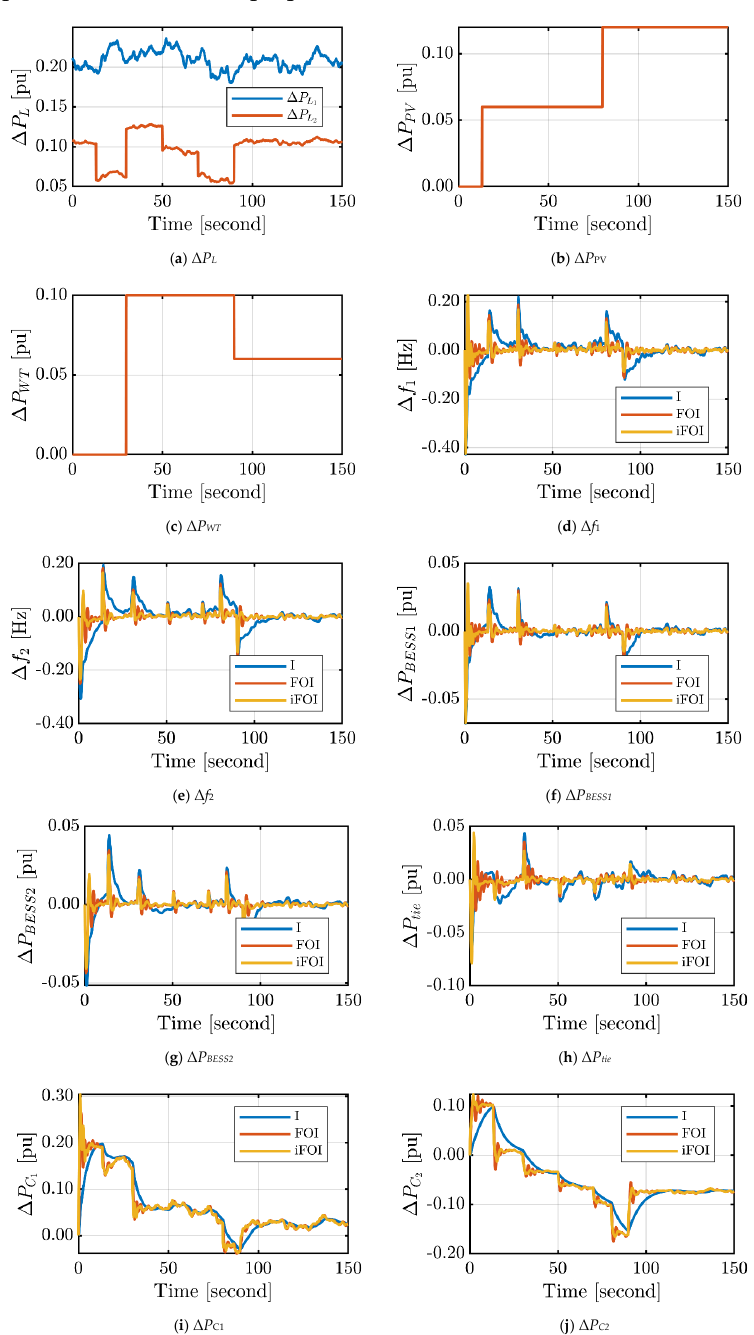
Figure 10. Dynamic response of the two-area power system in case 3.